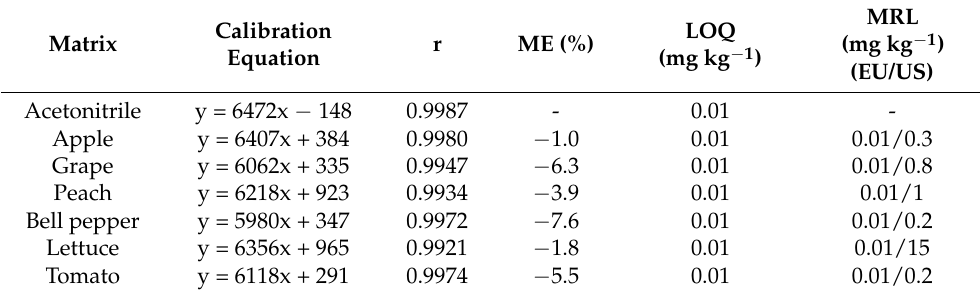
Table 1. Information on calibration, ME, LOQs, and MRLs of CYCP in different